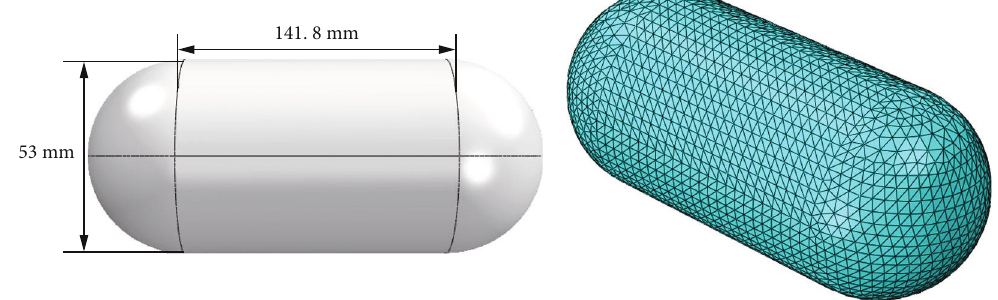
Figure 9: Bird body solid and mesh diagram. Table 9: Bird body material parameters.